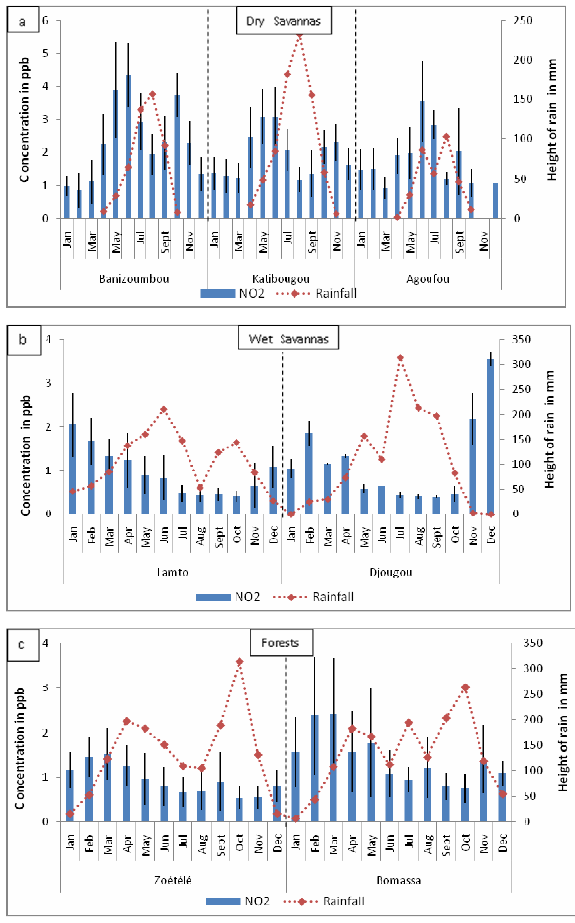
Figure 5 : Evolution of monthly NO 2 concentrations on the transect dry savannas (5a), wet savannas (5b), forests (5c). Fig. 5. Evolution of monthly NO 2 concentrations on the transect dry savannas (a) , wet savannas (b) , forests (c) .